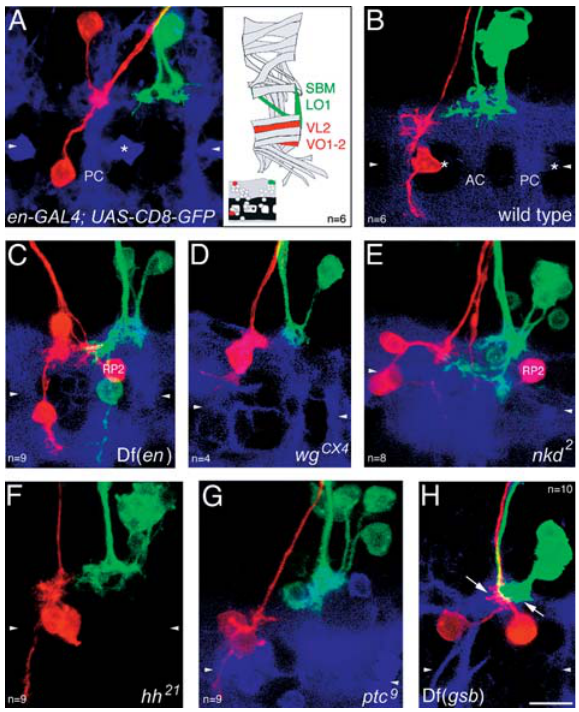
Figure 4. Parasegmental Organisation of the Motor System (A) Distribution of motor neuron dendritic arbors relative to the domains of en expression. Neurons expressing the en gene were visualised (blue) using en-GAL4;UAS-CD8-GFP . ISN motor neuron dendrites (red) elaborate in the En domain (blue) of the neuromere, whereas SN motor neuron dendrites (green) form in the anterior half of the next posterior segment (asterisks indicate the segment borders). Thus, the motor system appears to be parasegmental in nature. The diagrams to the right indicate which motor neurons were labelled. (B–H) ISN motor neurons (red) with dorsal internal and SN motor neurons (green) with lateral external muscle targets were retro- gradely labelled in 15-h-old wild-type embryos (B) and those mutant for different segment polarity genes (C–H). (C) to (H) should be compared with the wild-type control in (B). As far as could be ascertained, similar sets of motor neurons were labelled in the wild- type (B) and mutants (C–H). The neuropile, visualised with anti-HRP, is shown in blue (except for [F]). In all mutant embryos, with the exception of Df(gsb) (H), ISN and SN motor neurons have separate nerve roots and dendritic fields, as in the wild-type. As (H) shows, in Df(gsb) mutant embryos, ISN and SN nerve roots are frequently fused, yet the respective dendritic fields (arrows) do not appear to intermingle. Anterior is left and dorsal is up. Symbols and abbreviations: triangles, ventral midline; AC, anterior commissure; PC, posterior commissure (RP2 cell bodies, the most posterior of the ISN motor neurons, are indicated in [C] and [E]); asterisks, dorsoventral channels (landmarks for the segment borders). Scale bar (not applicable to diagrams of CNS and muscle field): 10 l m. DOI: